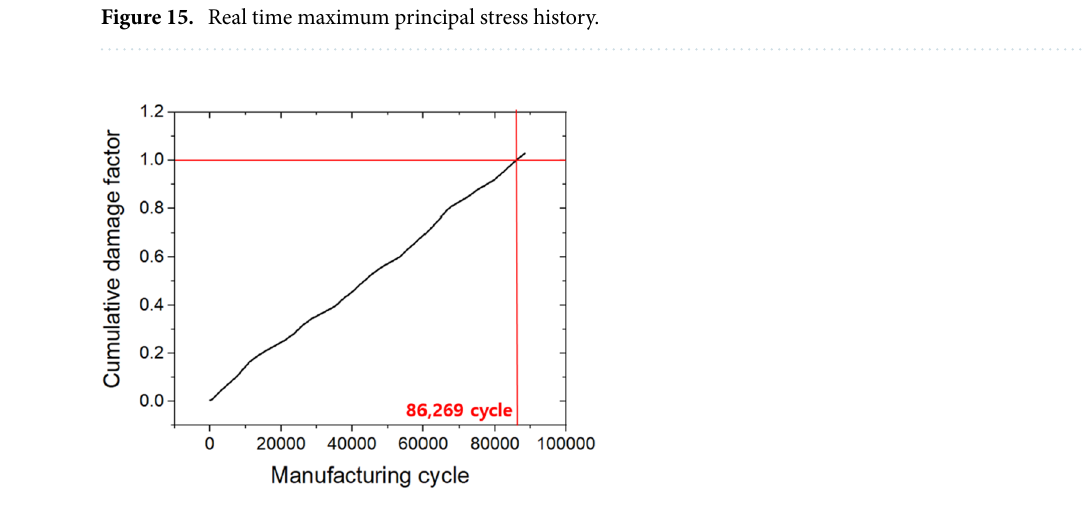
Figure 16. Die life cycle prediction based on cumulative damage factor.